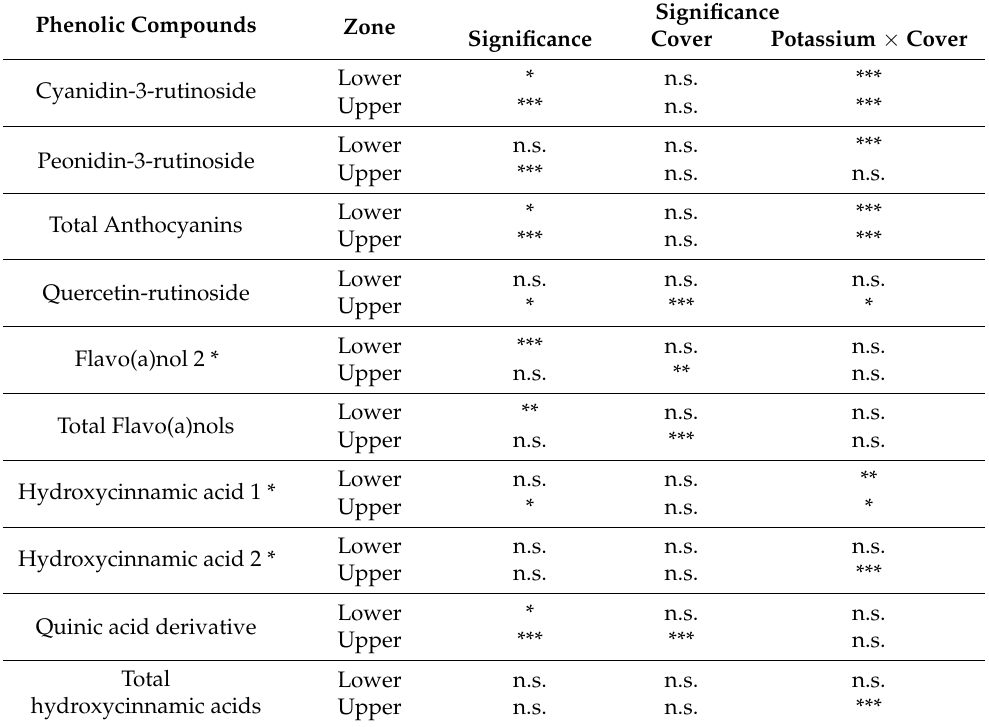
Table 6. The statistical significance of each studied factor and its interaction with phenolic compounds detected in cherry